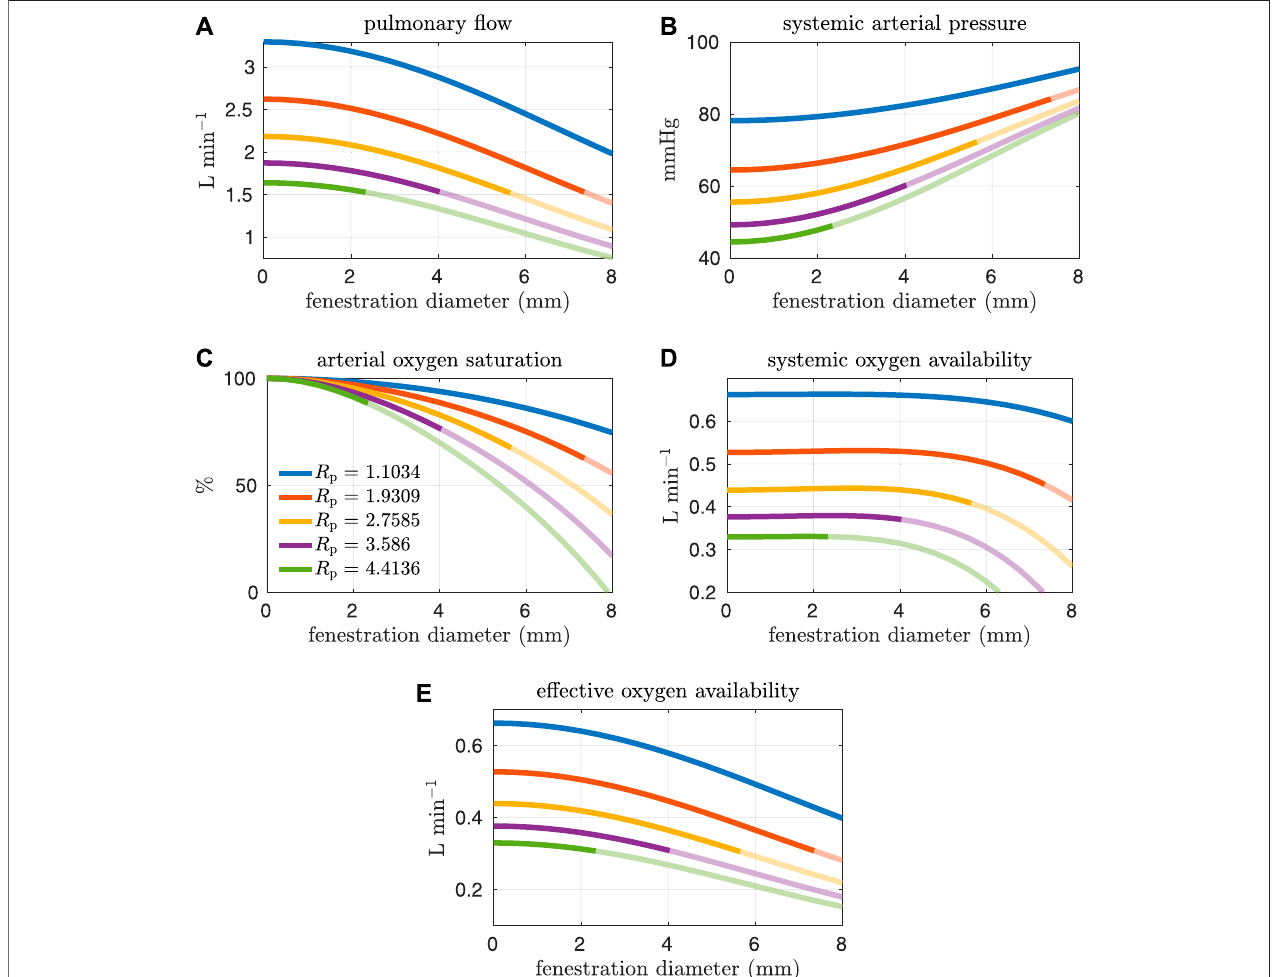
FIGURE 7 | Results corresponding to oxygen consumption equal to − 0.2 L min − 1 . Pulmonary resistance values R p larger than our baseline value are considered. Mean values for different hemodynamic and oxygen transport variables are plotted as functions of the fenestration diameter. Note that the systemic oxygen availability curves achieve an optimal value for a nonzero fenestration size. However, the effective oxygen availability, which is important for quantifying the supply of oxygen, monotonically decreases as the fenestration size increases. (A) pulmonary fl ow, (B) systemic arterial pressure, (C) arterial oxygen saturation, (D) systemic oxygen availability, (E) effective oxygen availability.